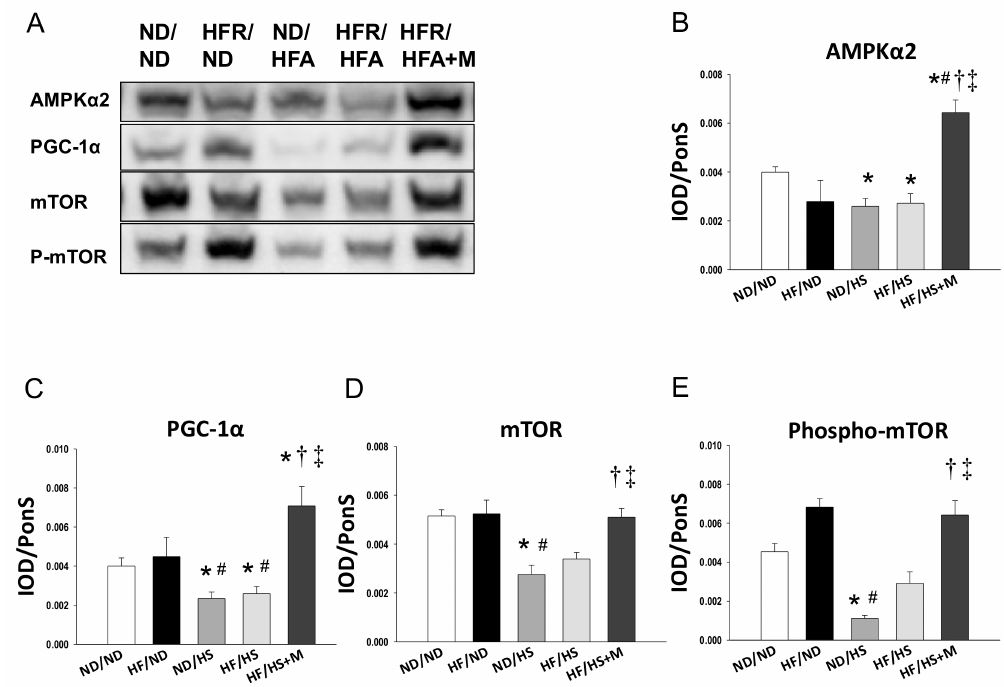
Figure 3. ( A ) Representative Western blots and relative abundance of ( B ) AMPK α 2 (63 kDa); ( C ) PGC-1 α (90 kDa); ( D ) mammalian target of rapamycin (mTOR, 289kDa) and ( E ) phosphorylated mTOR in male offspring kidneys at 12 weeks of age. * p < 0.05 vs. ND/ND, # p < 0.05 vs. HF/ND, † p < 0.05 vs. ND/HS, ‡ p < 0.05 vs. HF/HS.